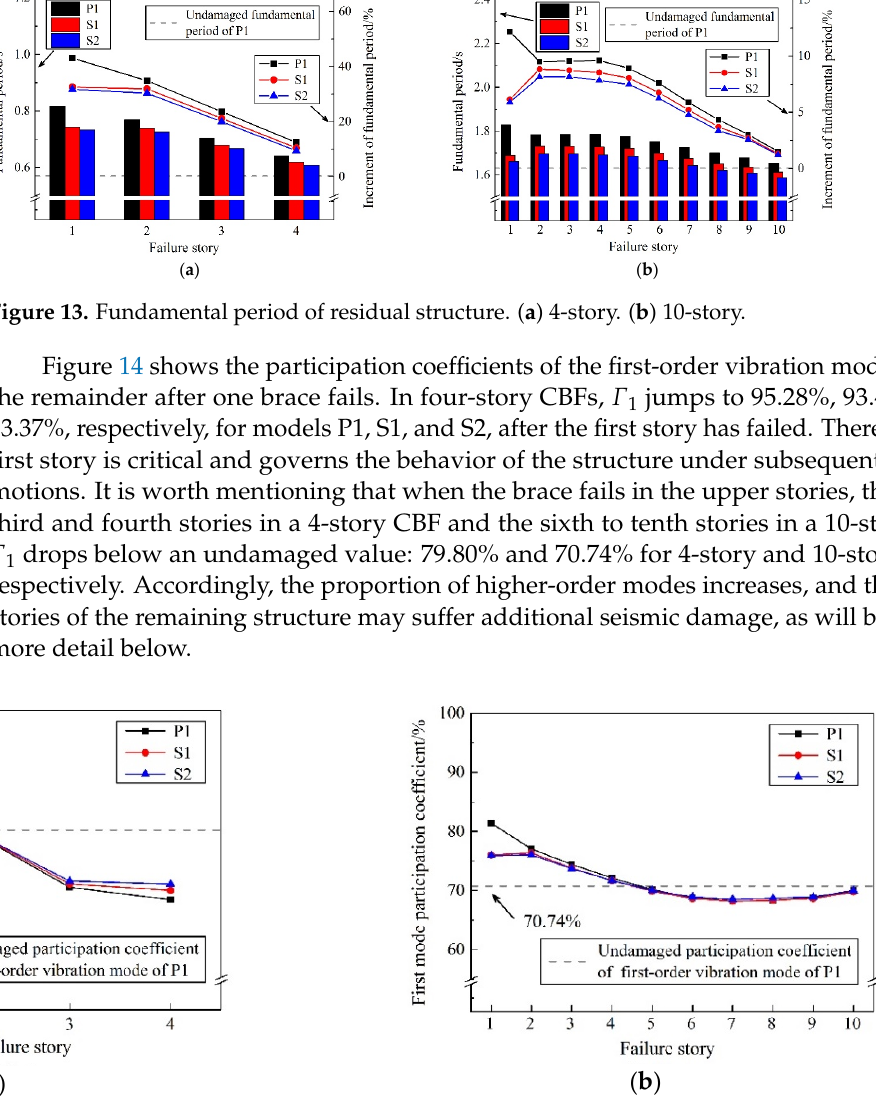
Figure 14. First-mode participation coefficient of residual structure. ( a ) 4-story; ( b )